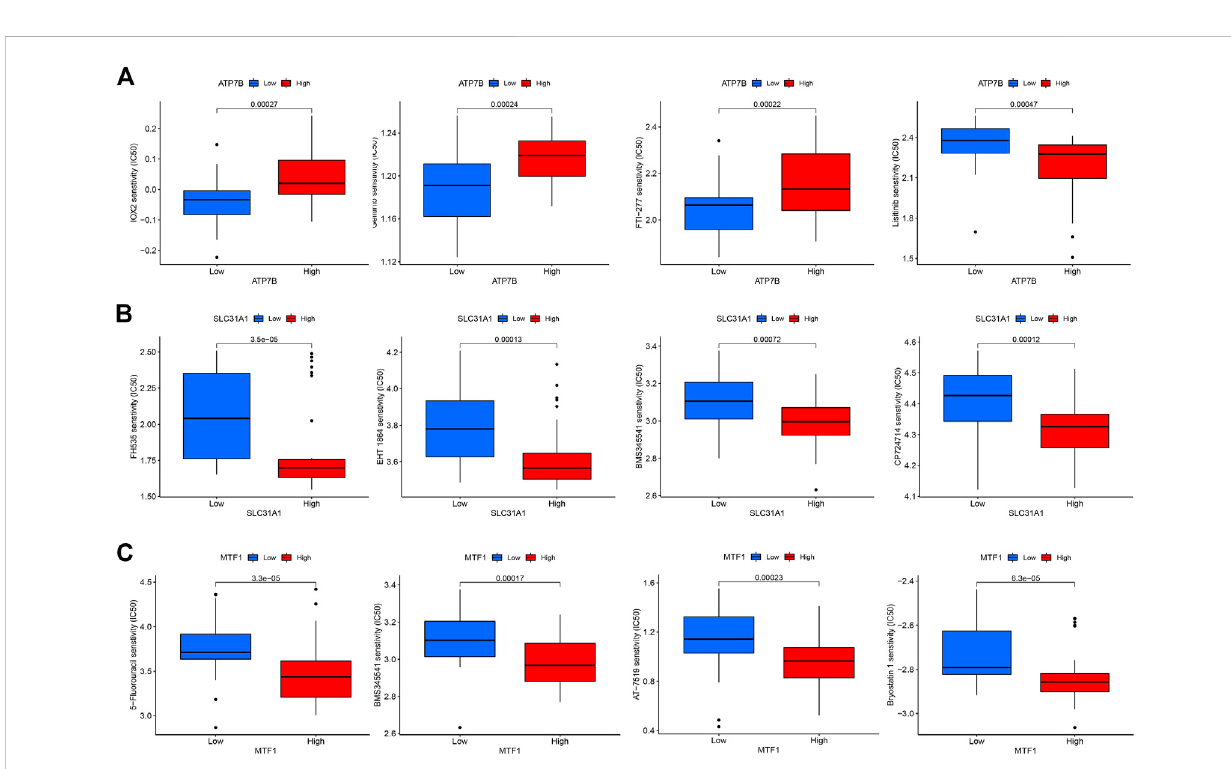
FIGURE 9 The drug sensitivity analysis of potential drugs for the treatment of psoriasis. (A) Sensitivity of ATP7B in different drugs. (B) Sensitivity of SLC31A1 in different drugs. (C) Sensitivity of MTF1 in different drugs.